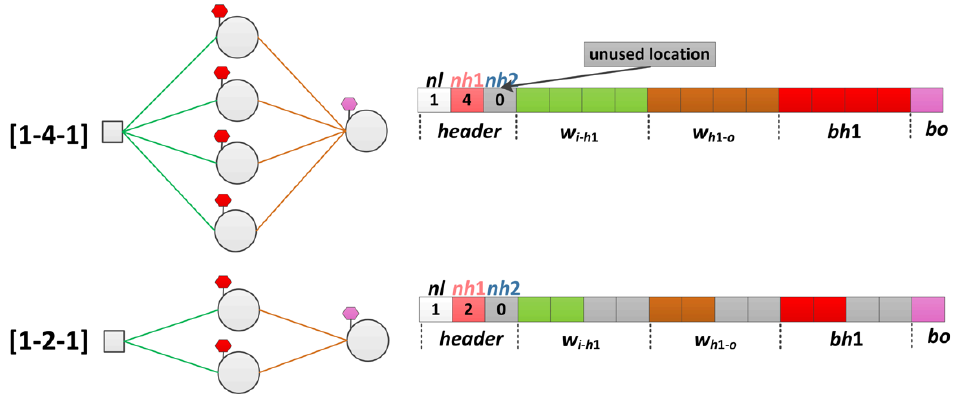
Figure 3. Example of two different MLPs that are associated with an array of the same length.